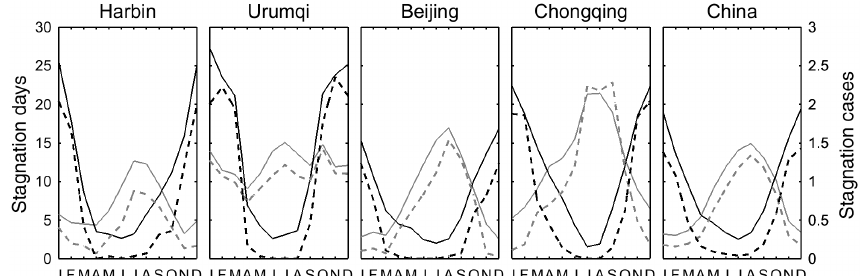
Figure 10. Annual cycles of air stagnation days and cases of four representative stations (Harbin, Urumqi, Beijing, and Chongqing), as well as the national average values. Black and grey lines indicate stagnation conditions under the BSI and ASI metrics, respectively. Solid and dash lines represent stagnation days and cases,